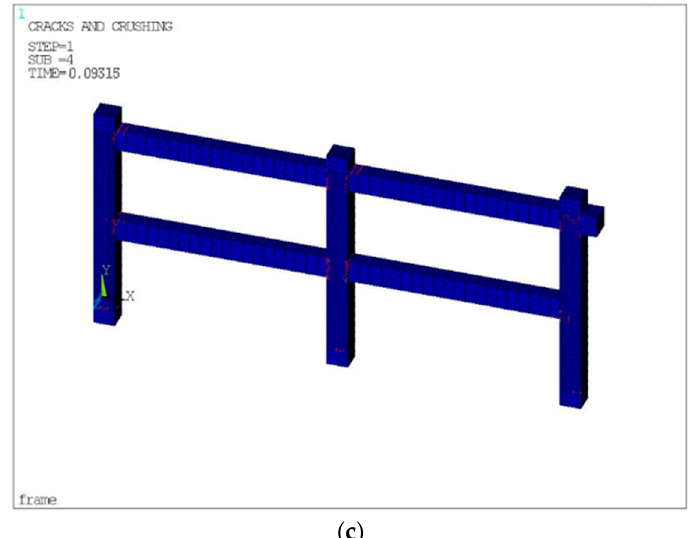
Figure 17. The diagram of KJ-3 result analysis. ( a ) Stress contour of frame under the ultimate load. ( b ) The X displacement contour of frame under the ultimate load. ( c ) Cracks of frame under the ultimate load.